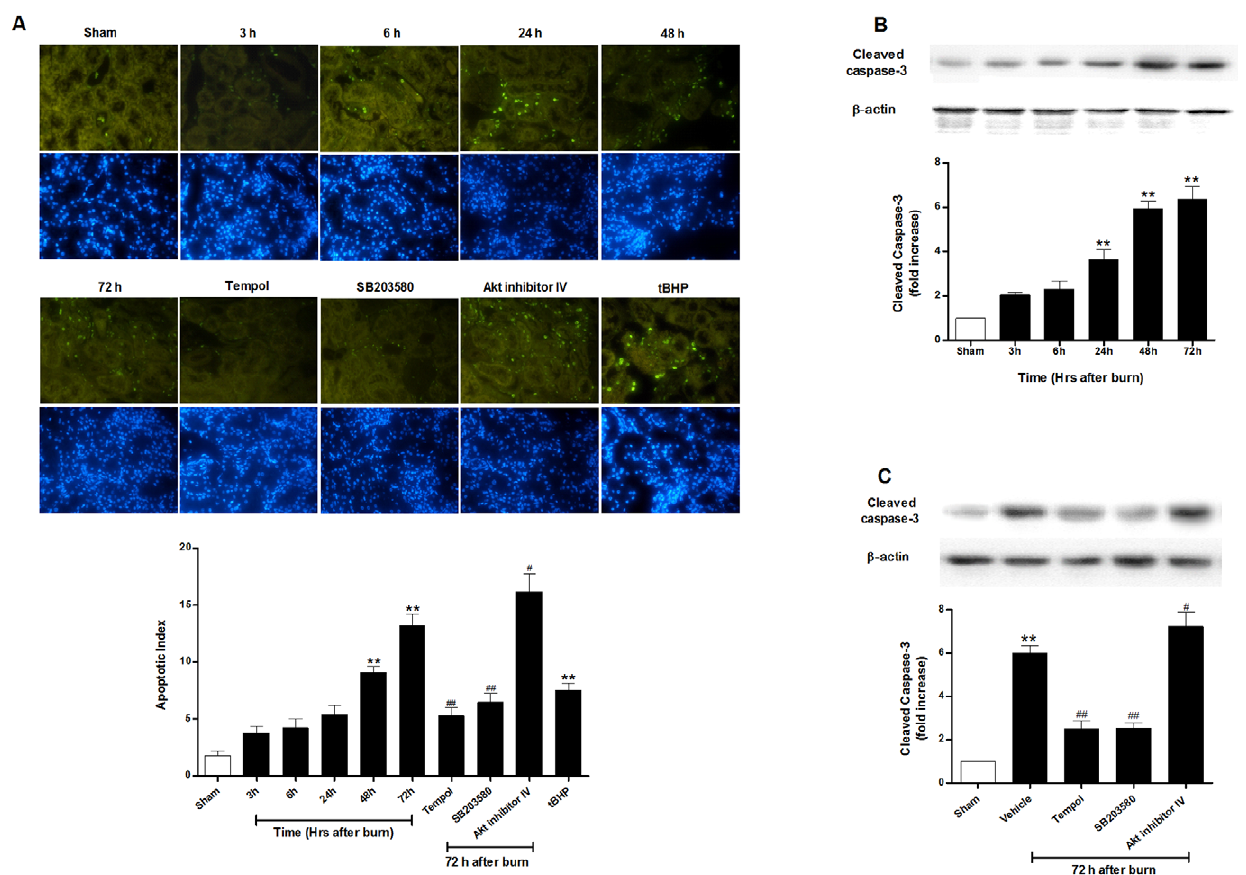
Figure 3. Tubular cell apoptosis and caspase-3 activation in rats after burn. Burn induced ( A ) tubular apoptosis presented by renal TUNEL staining (magnification =400 6 ) and increased caspase-3 activation ( B ) at different time points of 3 h, 6 h, 24 h, 48 h and 72 h ( C ) with different treatments at 72 h postburn. The data showed that burn induced increased caspase-3 activation and tubular cell apoptosis at a relatively late time stage postburn. Inhibition of ROS production and p38 MAPK phosphorylation alleviated renal apoptotic injury, while blockage of Akt expression aggravated the apoptosis in late renal failure after burn. Administration of tBHP led to obvious apoptotic kidney injury. ** P , 0.01 vs. Sham; # P , 0.05, ## P , 0.01 vs. Vehicle (72 h). n=6 rats per group per time